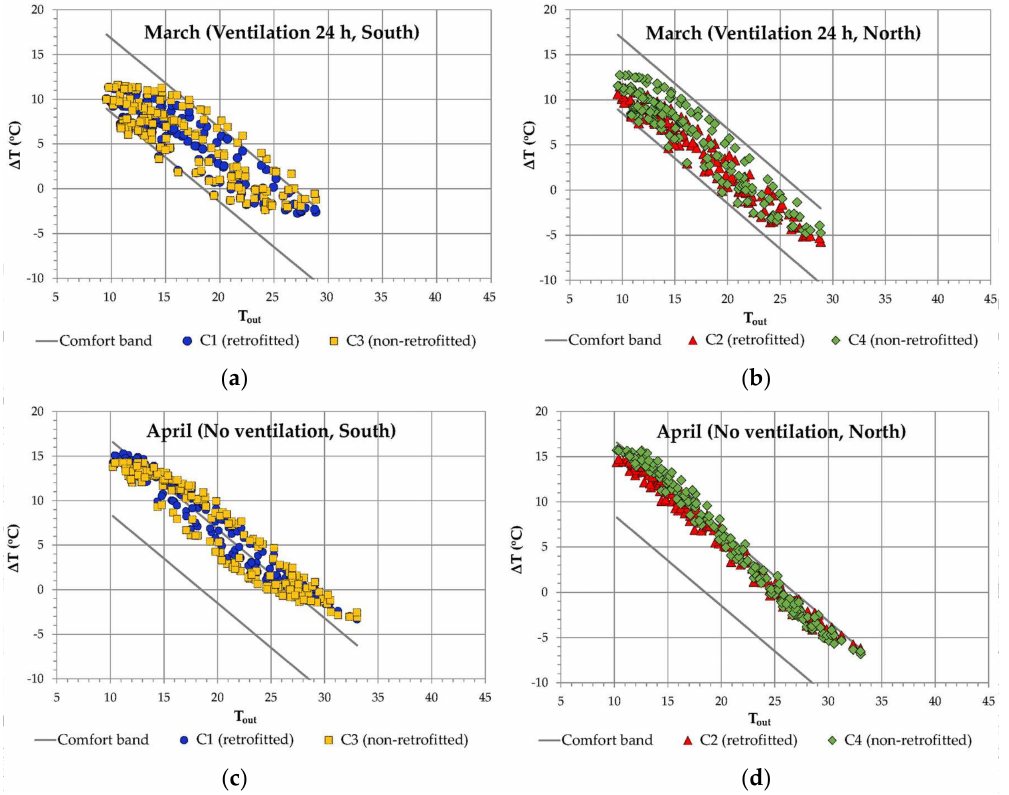
Figure 11. Dispersion diagrams. March protocol: ( a ) south cells; and ( b ) north cells. April protocol: ( c ) south cells; and ( d ) north